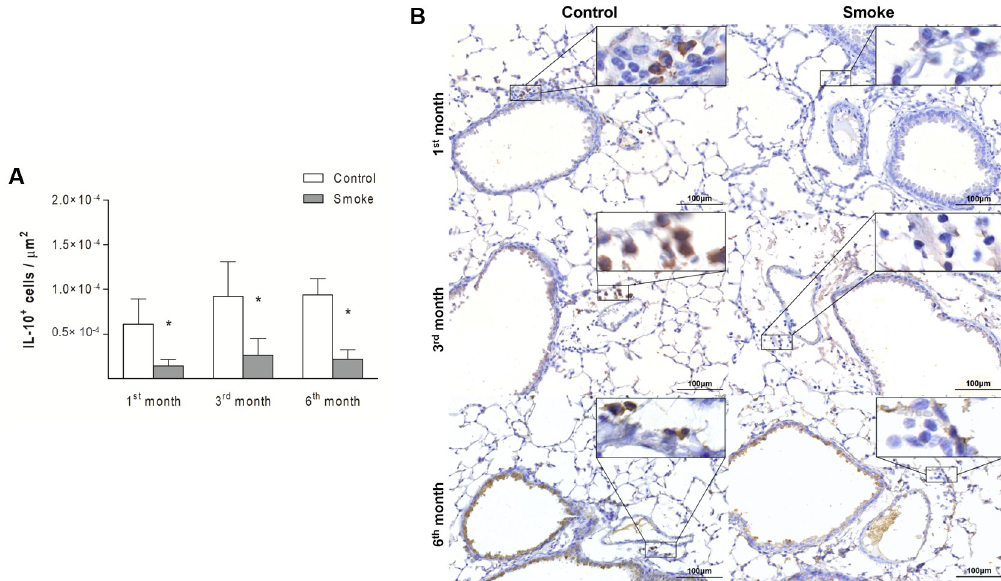
Fig 10. IL-10 + cells in peribronchovascular areas. The numbers of IL-10 + cells in peribronchovascular areas obtained for the Control groups after 1 (n = 9), 3 (n = 7), and 6 (n = 5) months and Smoke groups after 1 (n = 10), 3 (n = 6), and 6 (n = 9) months are presented as the means ± SDs. (A) Significant differences were found after 1 ( � P = 0.0001, Mann-Whitney test), 3 ( � P = 0.0029, t-test), and 6 ( � P = 0.0001, t-test) months. (B) Representative photomicrographs of IL-10 + cells in peribronchovascular areas are shown at 200 × magnification, and images at 1000 × magnification are shown in each insert.